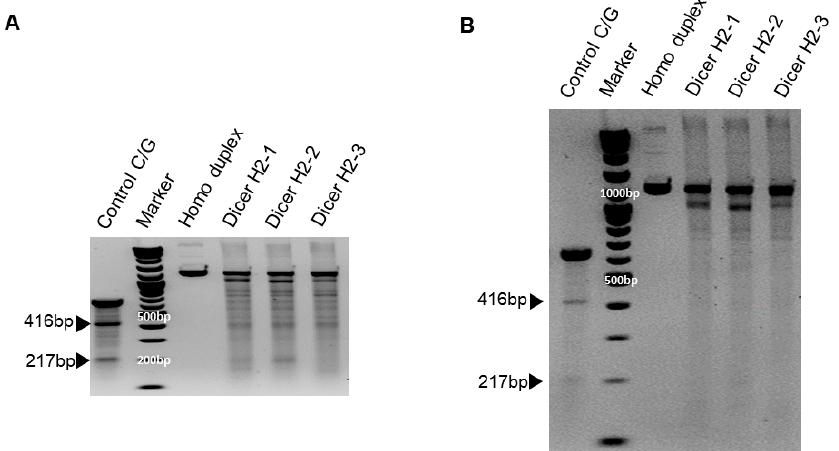
Figure 5. Surveyor assay comparing the efficiency of Cas9-mediated cleavage by double-nickase sgRNA in the human DICER locus. DNA duplex formation and treatment with a nuclease. SURVEYOR assay gel showing a comparable modification of control G/C, which is 633 base pair (bp) Control DNA with a point mutation (Supplementary Figure S1B) bearing 416 bp and 217 bp. Homoduplex without mismatch did not cleave the nuclease, but heteroduplex (Dicer H2-1, H2-2, and H2-3) shows the cleavage band. We ran the gel with short ( A ) and long ( B ) running times. Arrowheads indicate cleavage products.